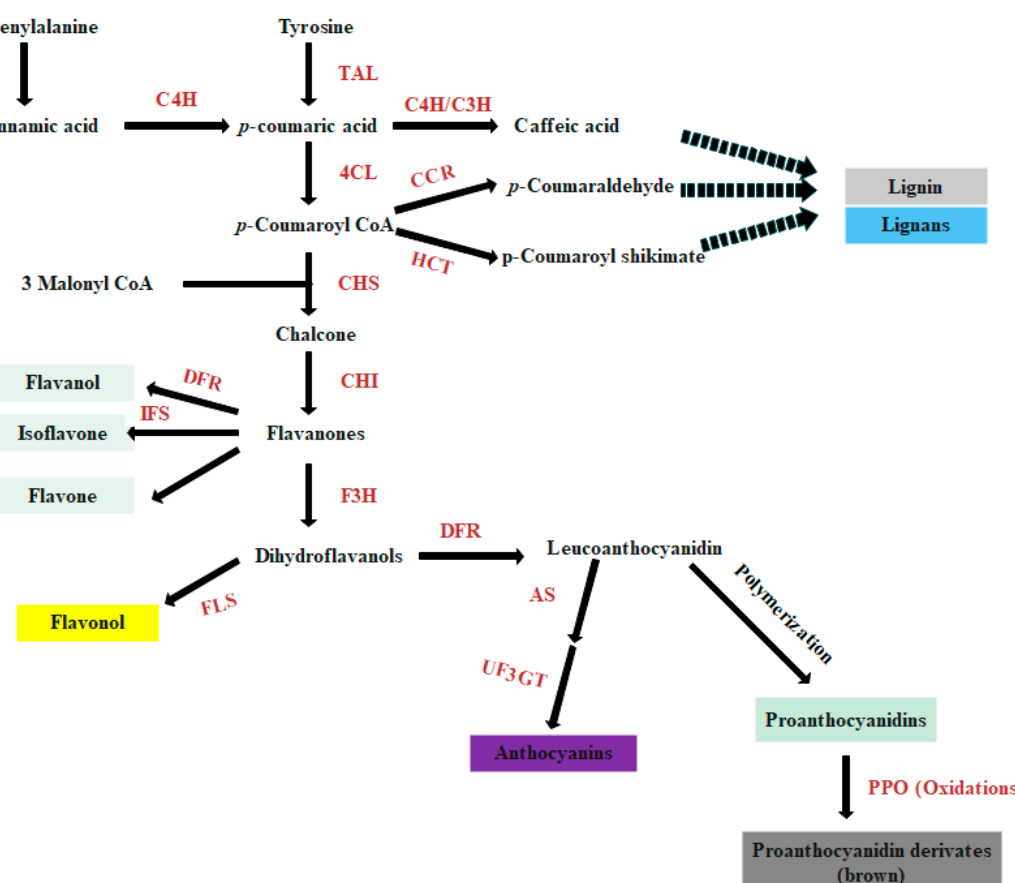
Figure 1. A diagram of the general biosynthetic pathway of phenylpropanoid leading to the main subgroups, and including lignin and flavonoids. Key enzymes catalyzing some reactions: PAL, phenylalanine amonialyase; C4H, cinnamate 4 ‐ hydroxylase; 4CL, 4 coumaroyl ‐ coenzyme A ligase; CHS, chalcone synthase; CHI, chalcone isomerase; F3H, flavanone 3 ’ ‐ hydroxylase; DFR, dihydroflavonol 4 ‐ reductase; FLS, flavonol synthase; IFS, isoflavonoid synthase; AS, anthocianin synthase; UF3GT, UDP glucose: flavonoid 3 ‐ O ‐ glucosyltransferase; TAL, Tyrosine ammonia ‐ lyase; C3H, p ‐ Coumarate 3 ‐ hydroxylase; CCR, Cinnamoyl ‐ CoA reductase; HCT, Hydroxycinnamoyl ‐ CoA shikimate/quinatehydroxycinnoyltransferase; and PPO, Polyphenol oxidase. Adapted from ref [16,18,19].